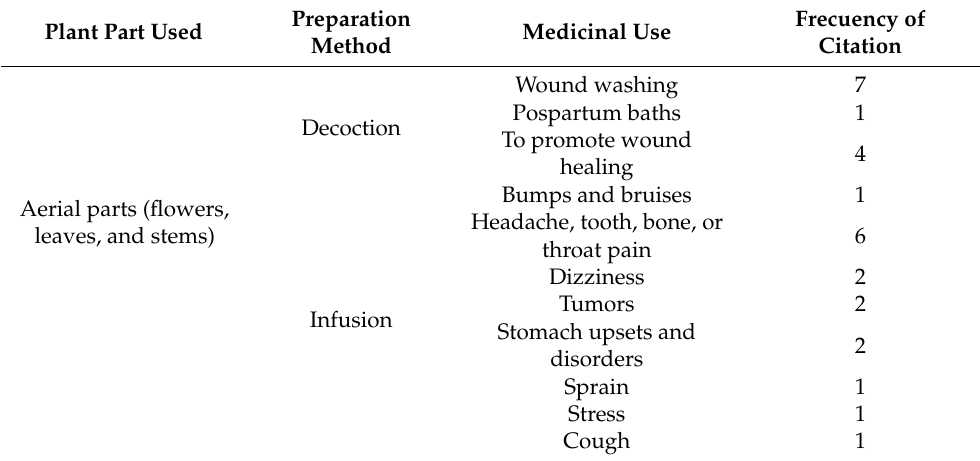
Table 3. Medicinal uses of Cuphea aequipetala Cav., parts of the plant used, and forms of preparation mentioned by the people